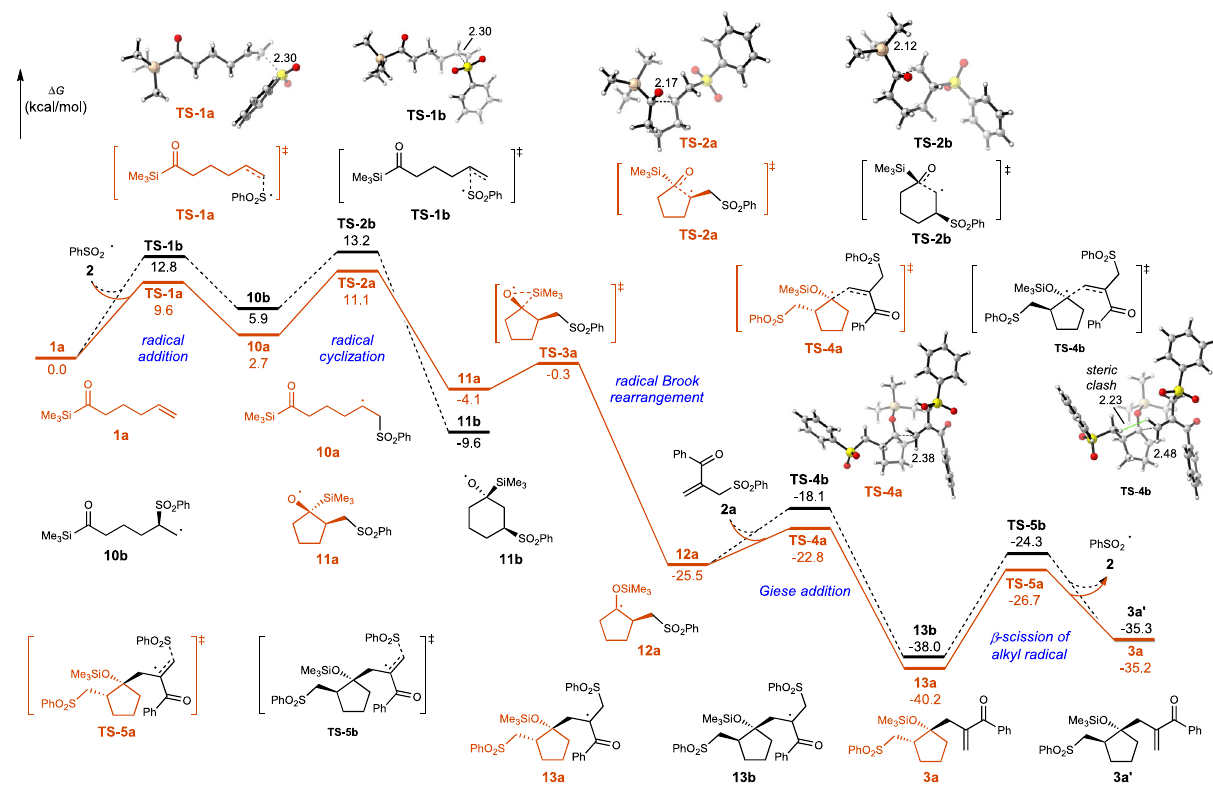
Fig. 8 |Computationalstudy oftheradicalchainmechanisminPhSO 2 radicalinvolvedcascadecyclizationof alkene-tetheredacylsilane1a andallylicsulfone2a. All energies were calculated at M06-2X/6-311+G(d,p)/SMD(water)//M06-2X/6-31G(d) level of theory.